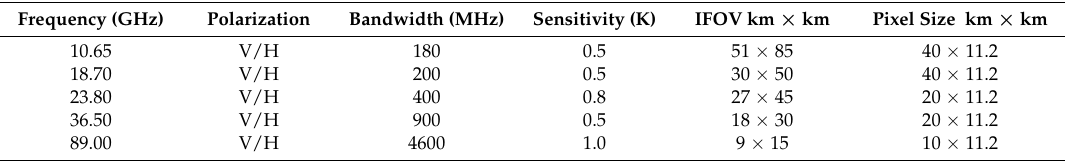
Table 2. Introduction to the microwave radiation imager